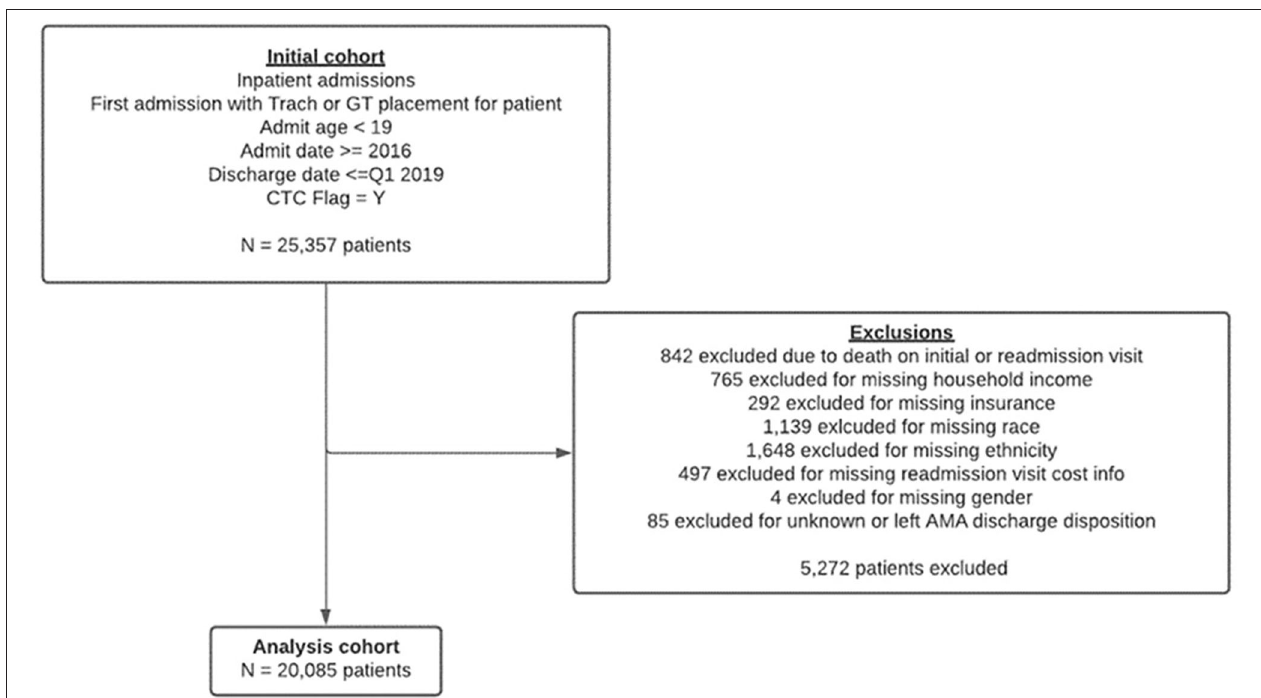
FIGURE 1 | Patient flow diagram showing inclusion and exclusion